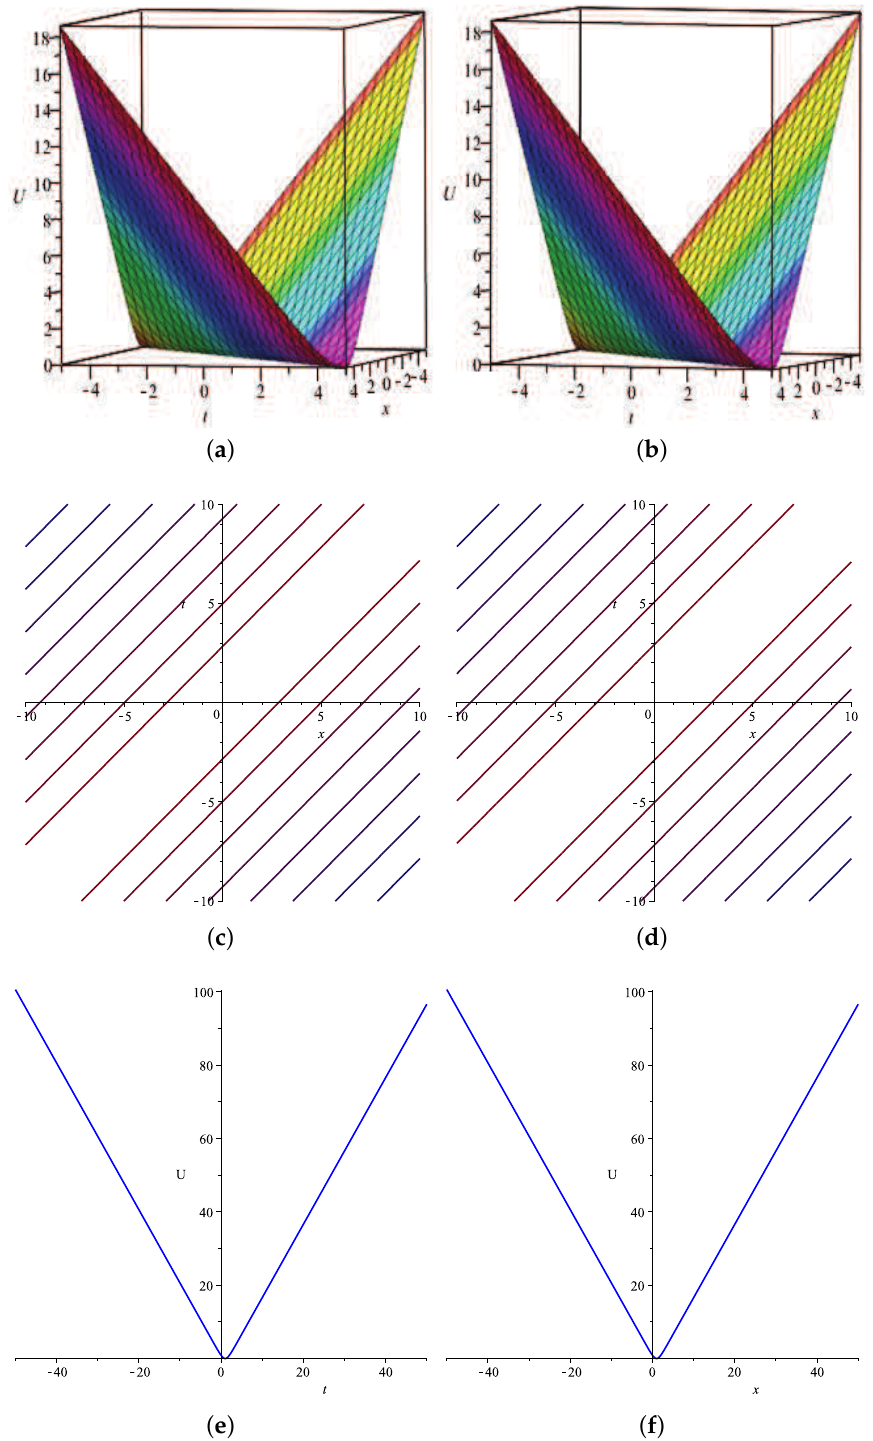
Figure 5. In ( a ), the graph of Equation (36) is given with β = 1, whereas, in ( b ), the graph of Equation (37) is given with β = 1 and α = 1. In ( c , d ), the 2D contours corresponding to the graphs ( a , b ) are given. ( e , f ) show 2D comparison of both solutions for x = 1 and t = 1,